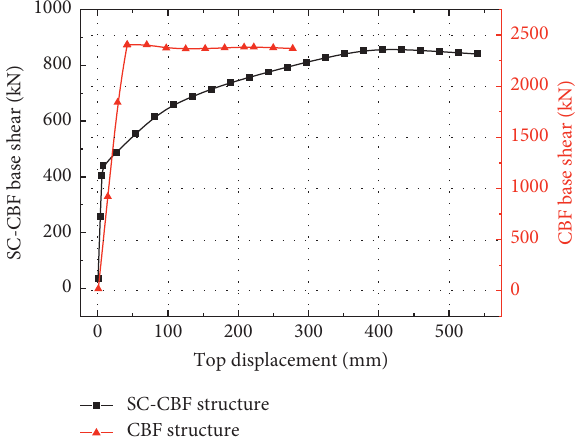
Figure 8: Pushover curves for SC-CBF and CBF